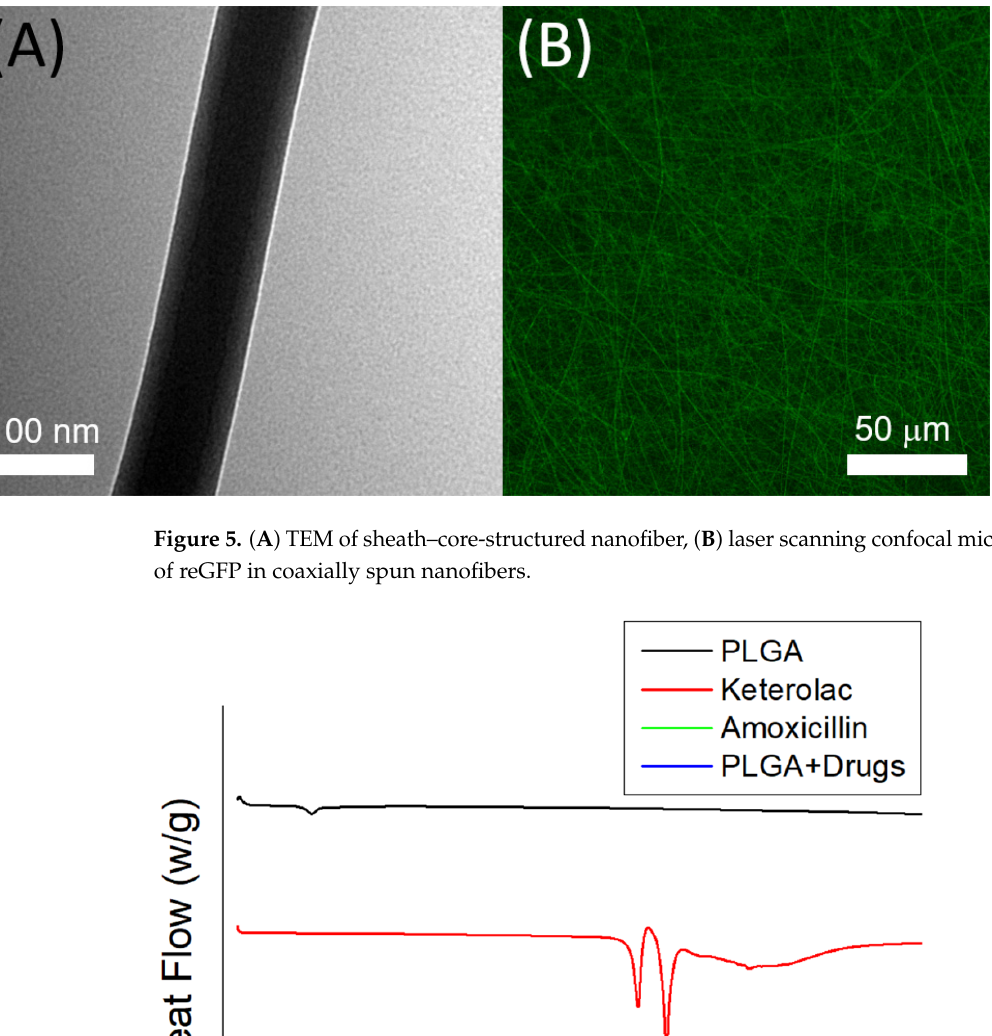
Figure 5. ( A ) TEM of sheath–core-structured nanofiber, ( B ) laser scanning confocal microscopic photo of reGFP in coaxially spun nanofibers.